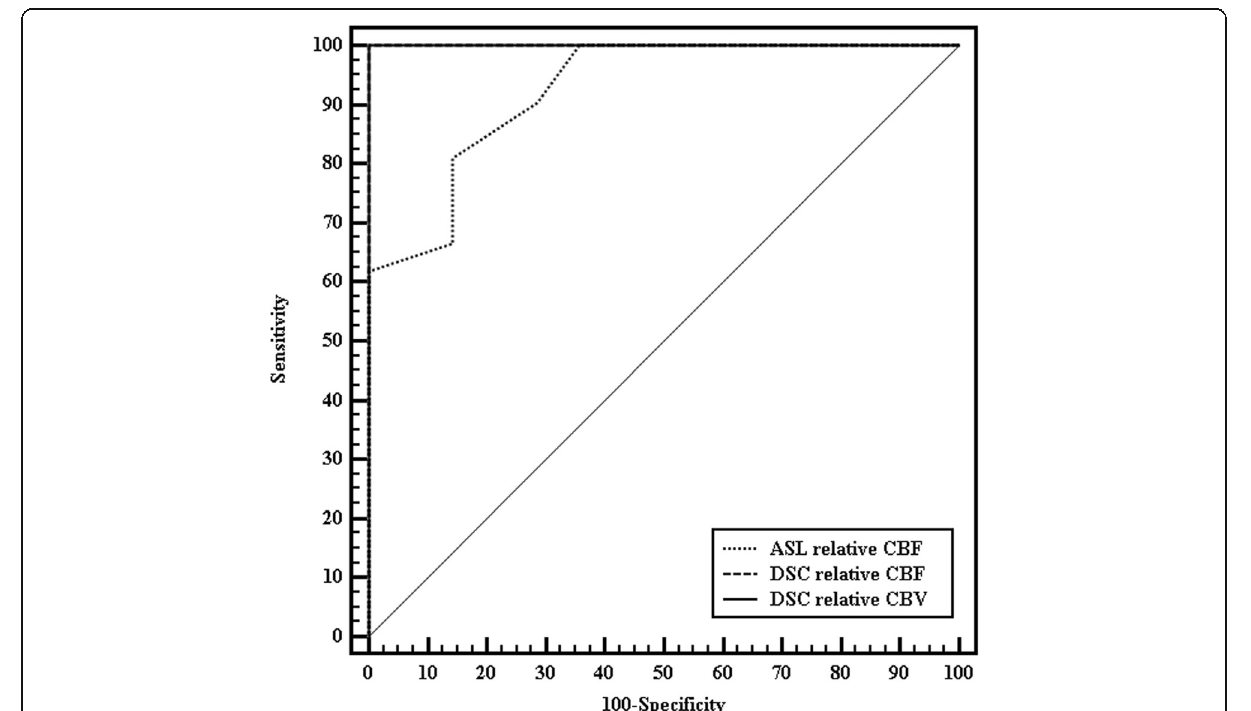
Fig. 4 ROC curve for ASL relative CBF (WM), DSC relative CBF (WM), and DSC relative CBV (WM) to differentiate high ( n = 21) from low ( n = 14) grade